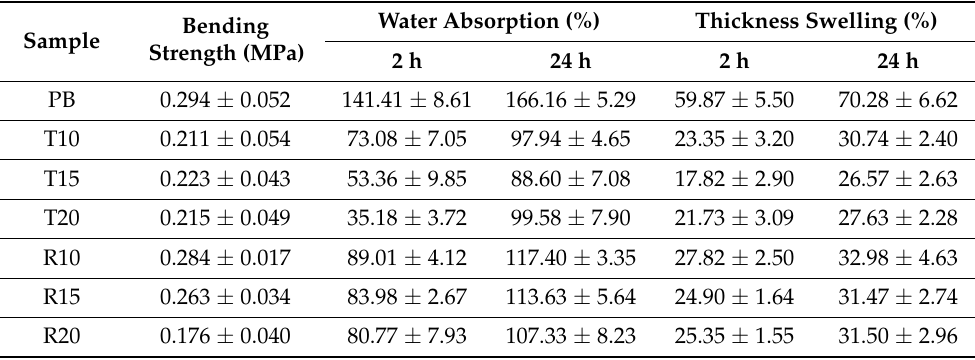
Table 2. Composite mechanical and physical properties.